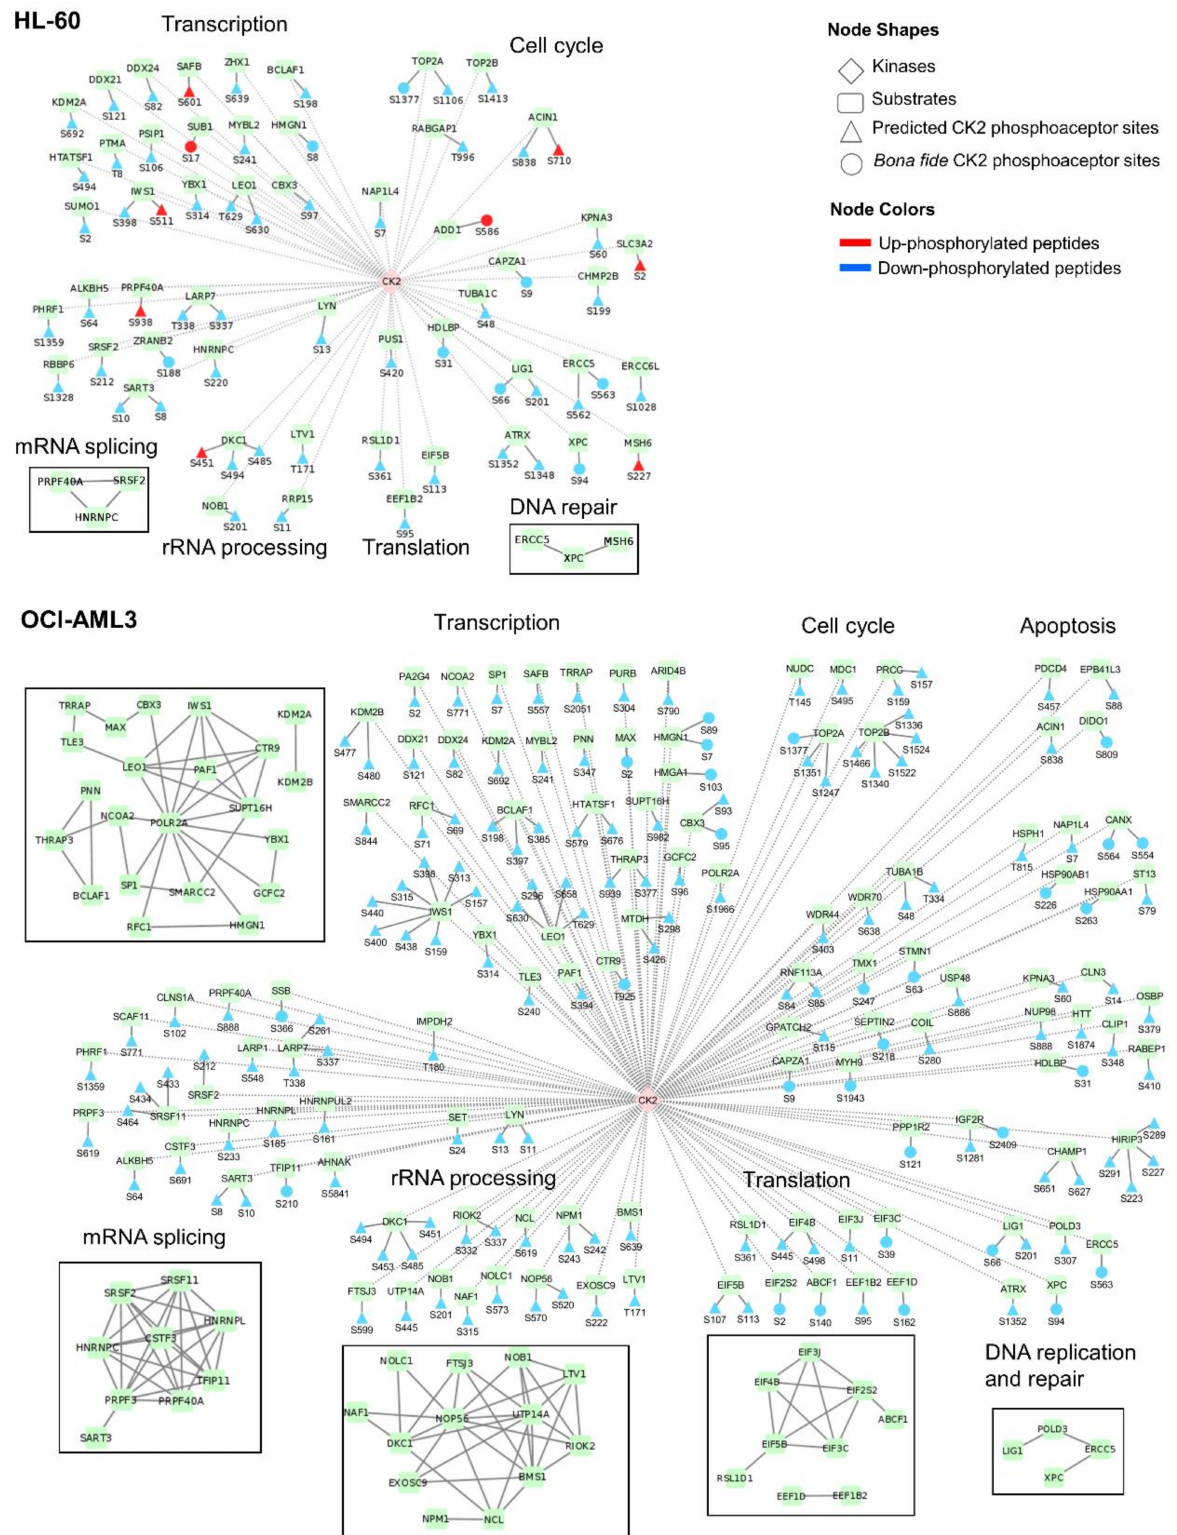
Figure 6. Network of CK2 substrates differentially modulated after CK2 inhibition with CX-4945 in AML cells. For each substrate, the phosphoacceptor sites (bona fide and predicted) for CK2-mediated phosphorylation and its modulation after incubation with CX-4945 are indicated. Phosphoproteins are grouped according to related biological processes annotated in GO database and squares representing protein-protein interactions networks retrieved from STRING database are